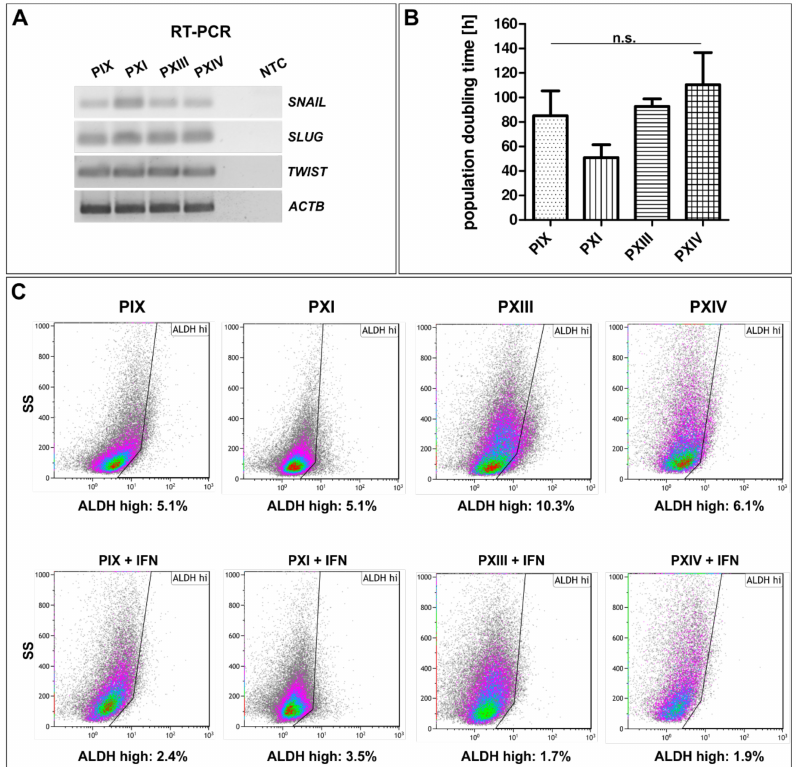
Figure 3. Gene expressions associated with epithelial-to-mesenchymal transition, proliferative behavior and aldehyde dehydrogenase activity analysis. ( A ) Target gene amplifications analyzed by reverse-transcription (RT) PCR of the epithelial-to-mesenchymal transition (EMT)-associated transcription factors SNAI1 ( SNAIL ), SNAI2 ( SLUG ) and TWIST in primary prostate cancer stem cells (PCSCs). Beta actin ( ACTB ) served as a housekeeping gene. ( B ) PCSC proliferation analyses showed population doubling times between 50 h (PXI) and 100 h (PXIV), which were not significantly different following Mann–Whitney U tests (for each population n = 3). Means are displayed as the standard error of the mean (SEM). ( C ) Flow cytometry of aldehyde dehydrogenase (ALDH) activities in PCSCs showed that up to 10% of cells had high ALDH protein expressions (PXIII, upper panel). These were reduced to less than 4% in the examined PCSC populations after pre-treatment with interferon gamma (lower